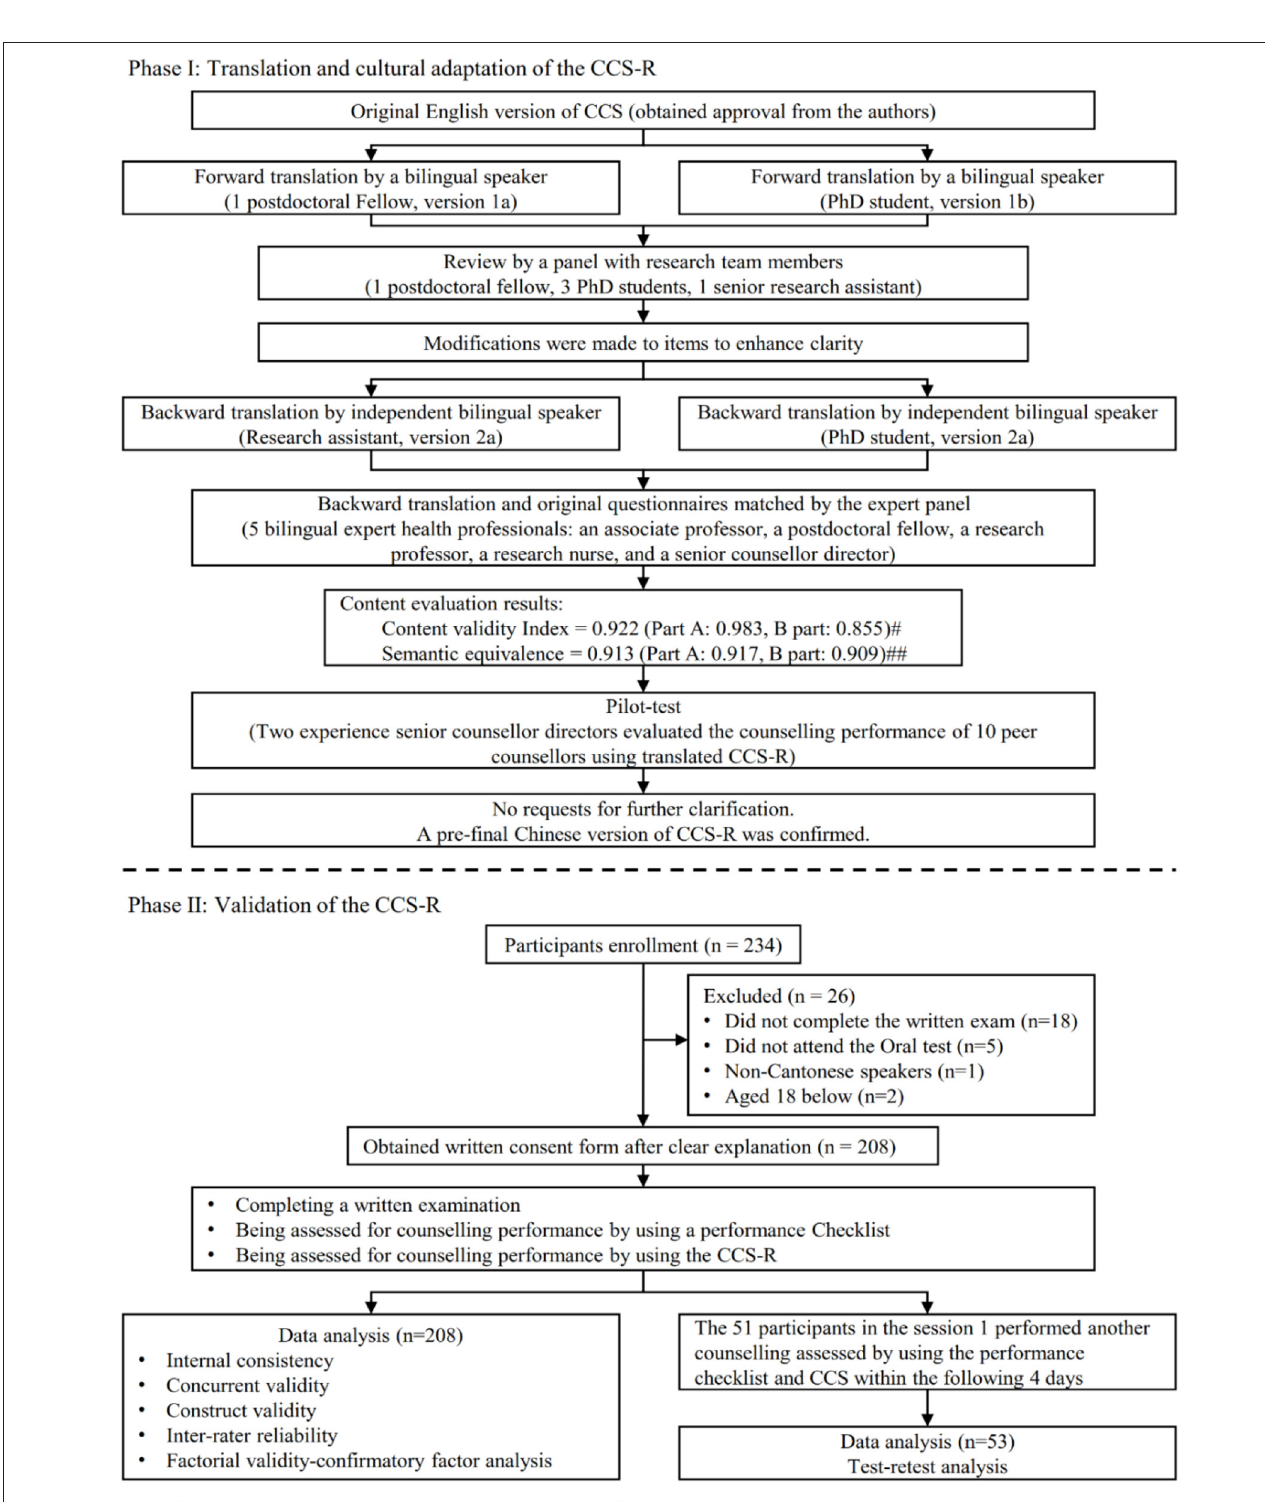
FIGURE 1 | Flowchart of materials and method for the translation and validation of the CCS-R.